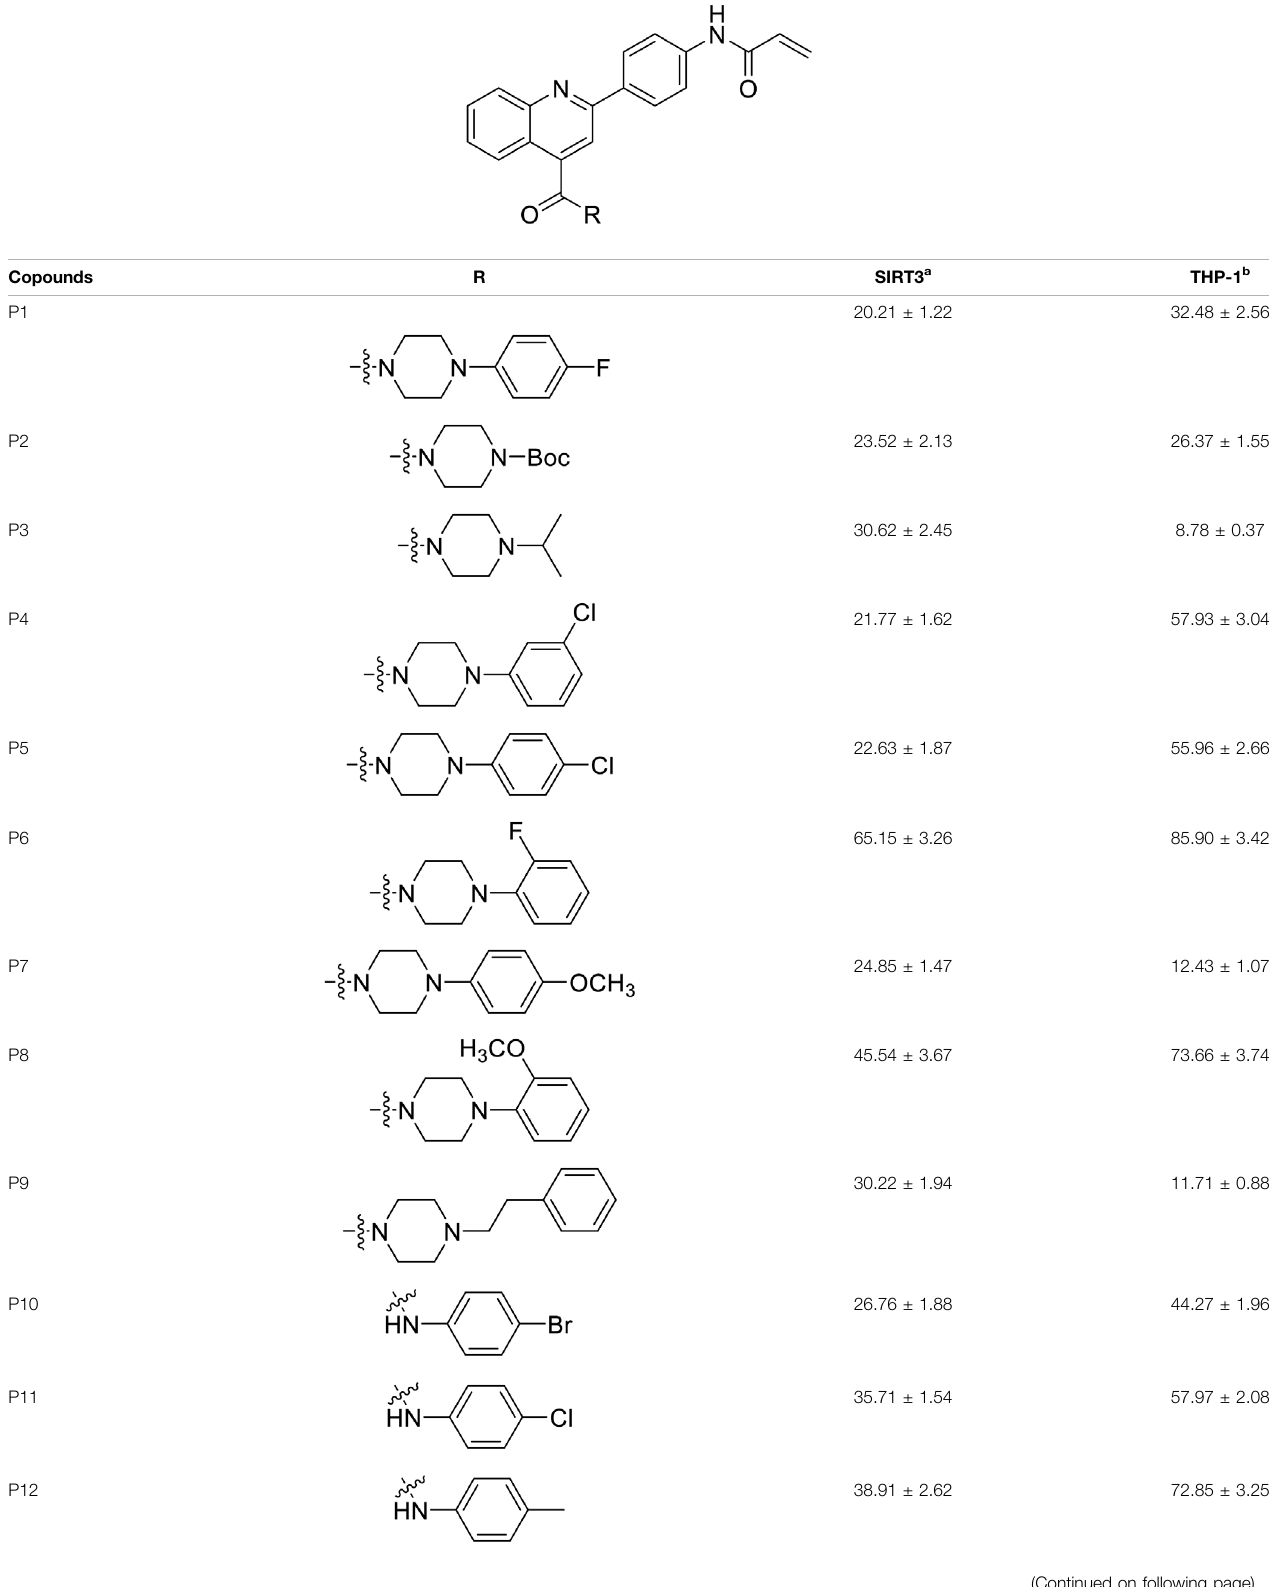
TABLE 1 | Structure, SIRT3 inhibitory and antiproliferative activity of the derived